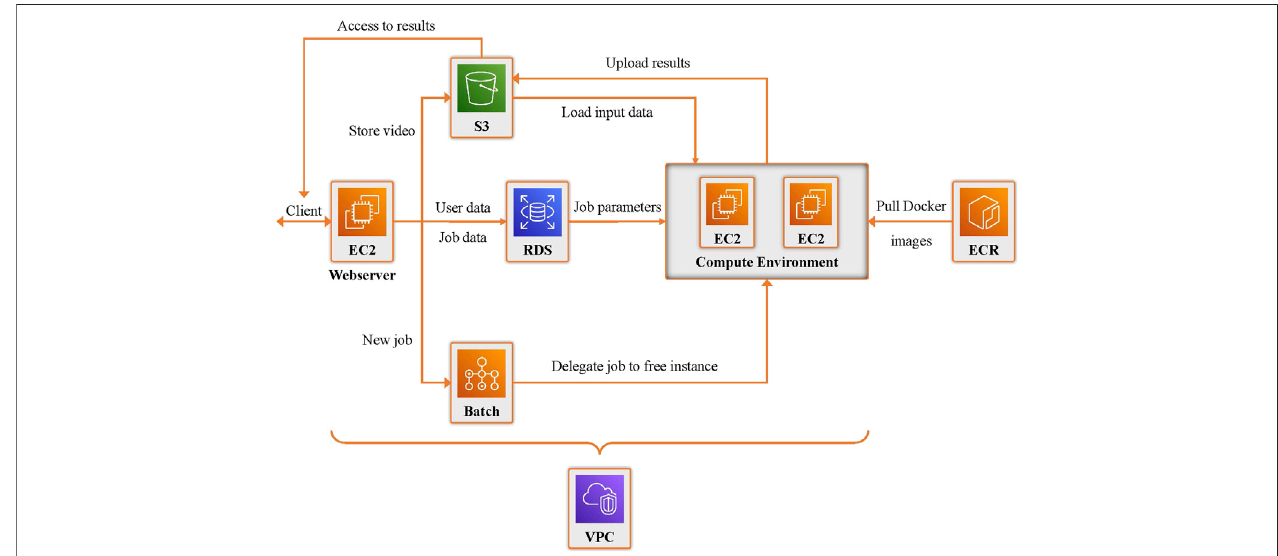
FIGURE 5 | Structure of the cloud architecture using AWS